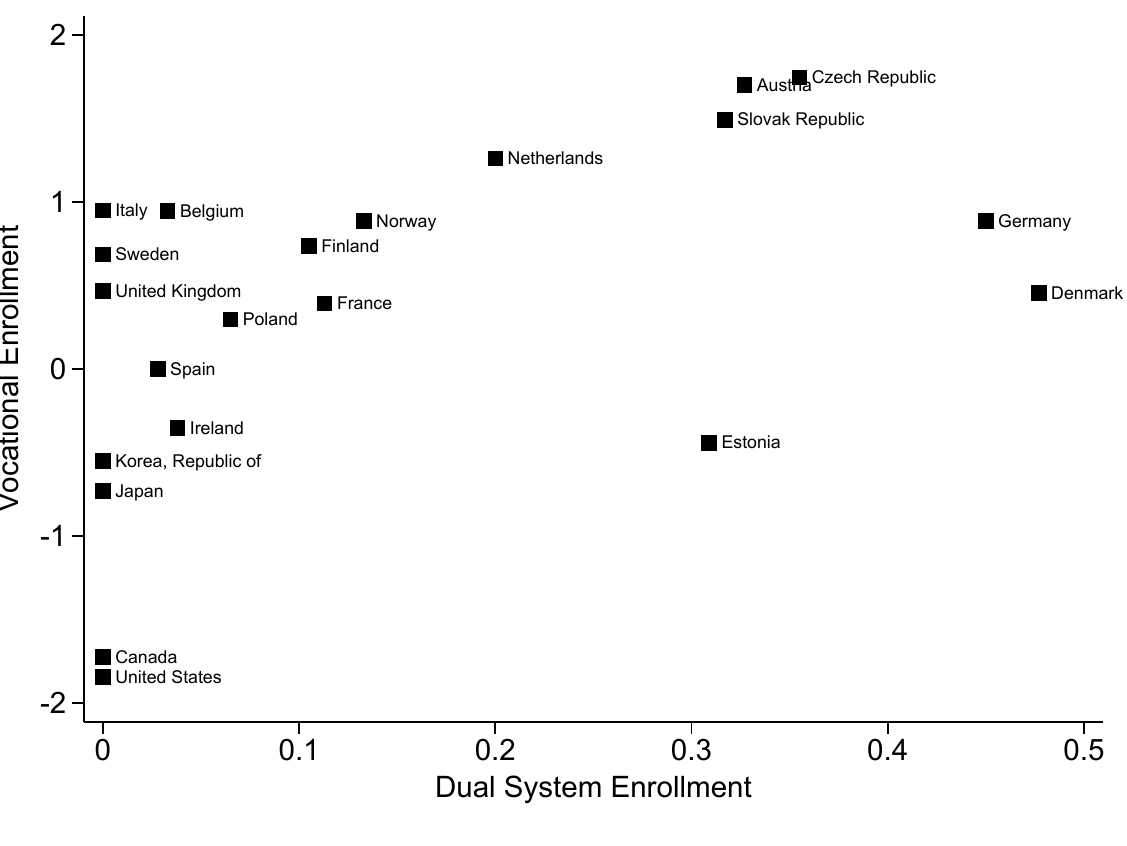
Figure 1: Correlation of the two country-level indicators vocational enrollment and dual system enrollment. Source: Bol and Van de Werfhorst (2013), version 4, own